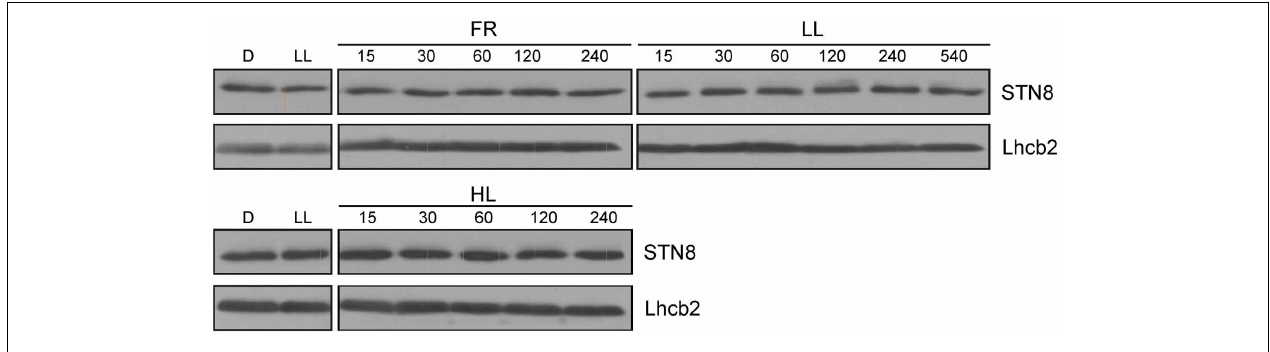
photons m − 2 s − 1 ) for an additional 4h. Leaf material was collected after each treatment and thylakoids were fractionated by SDS-PAGE and analyzed using antibodies specific for STN8 and Lhcb2 (loading